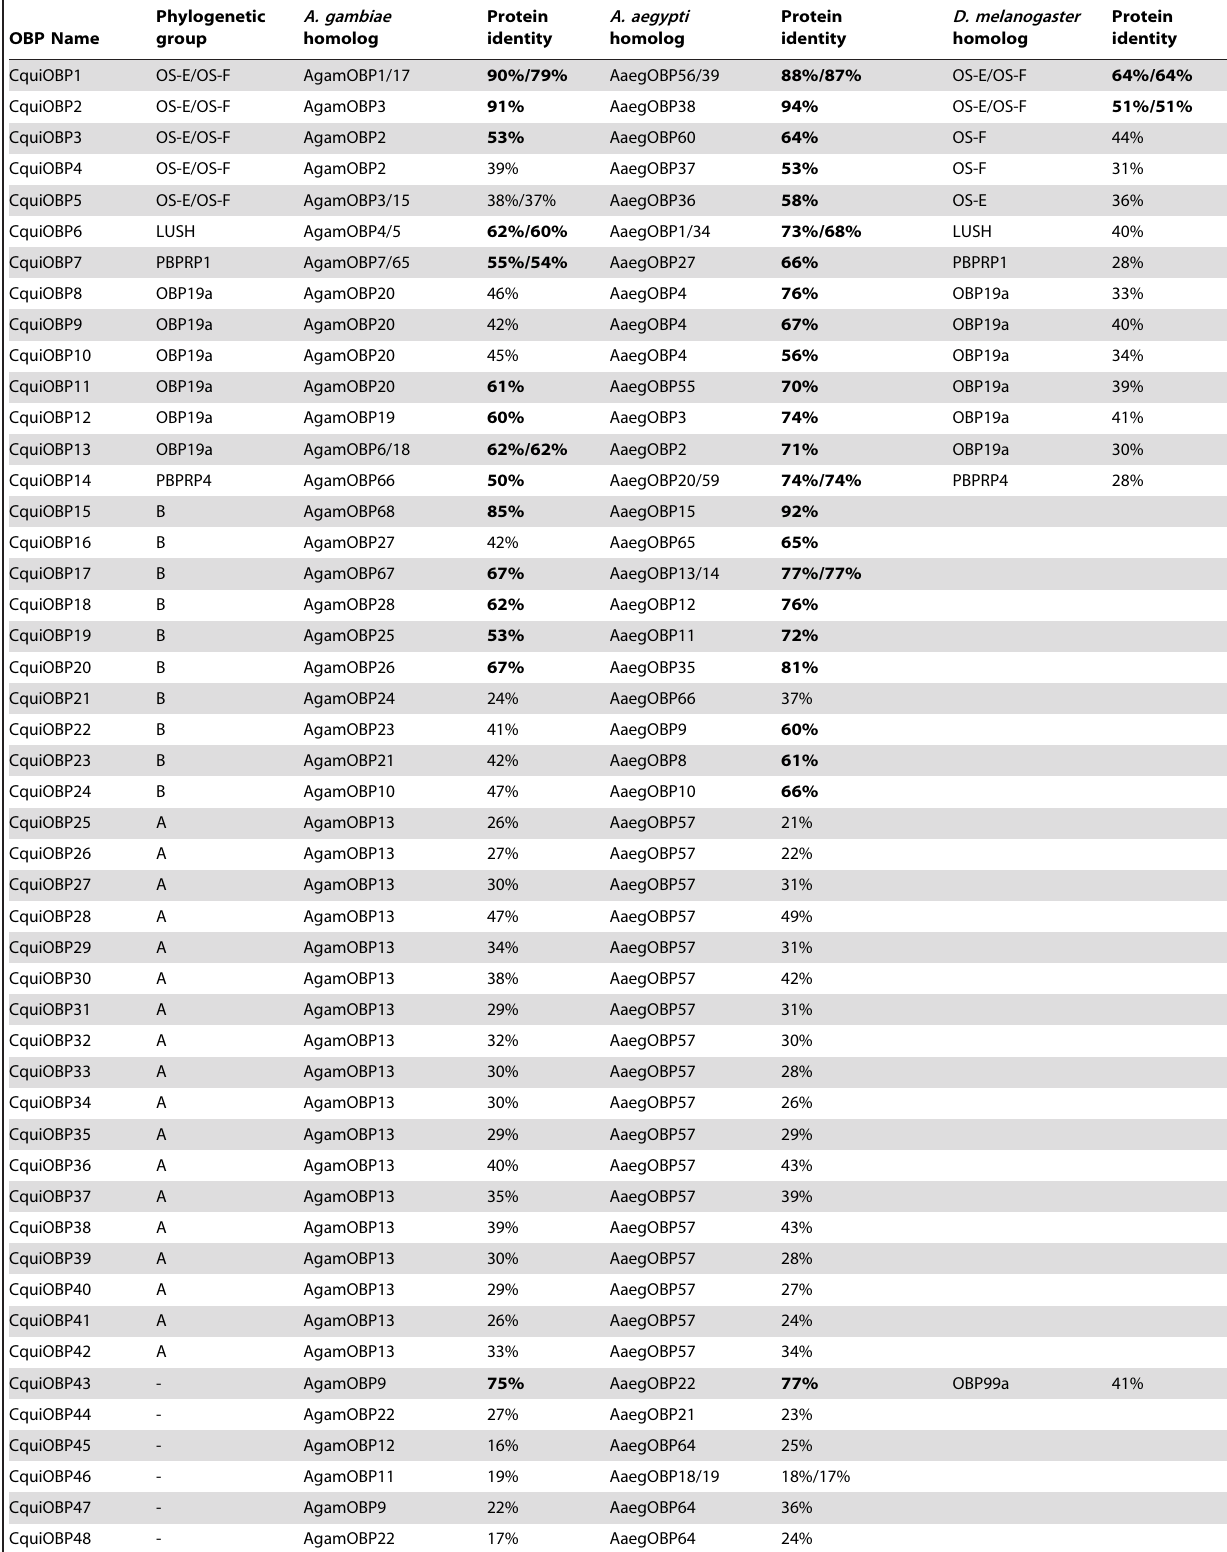
Table 2. Homology relationships of Cx. quinquefasciatus with other mosquito